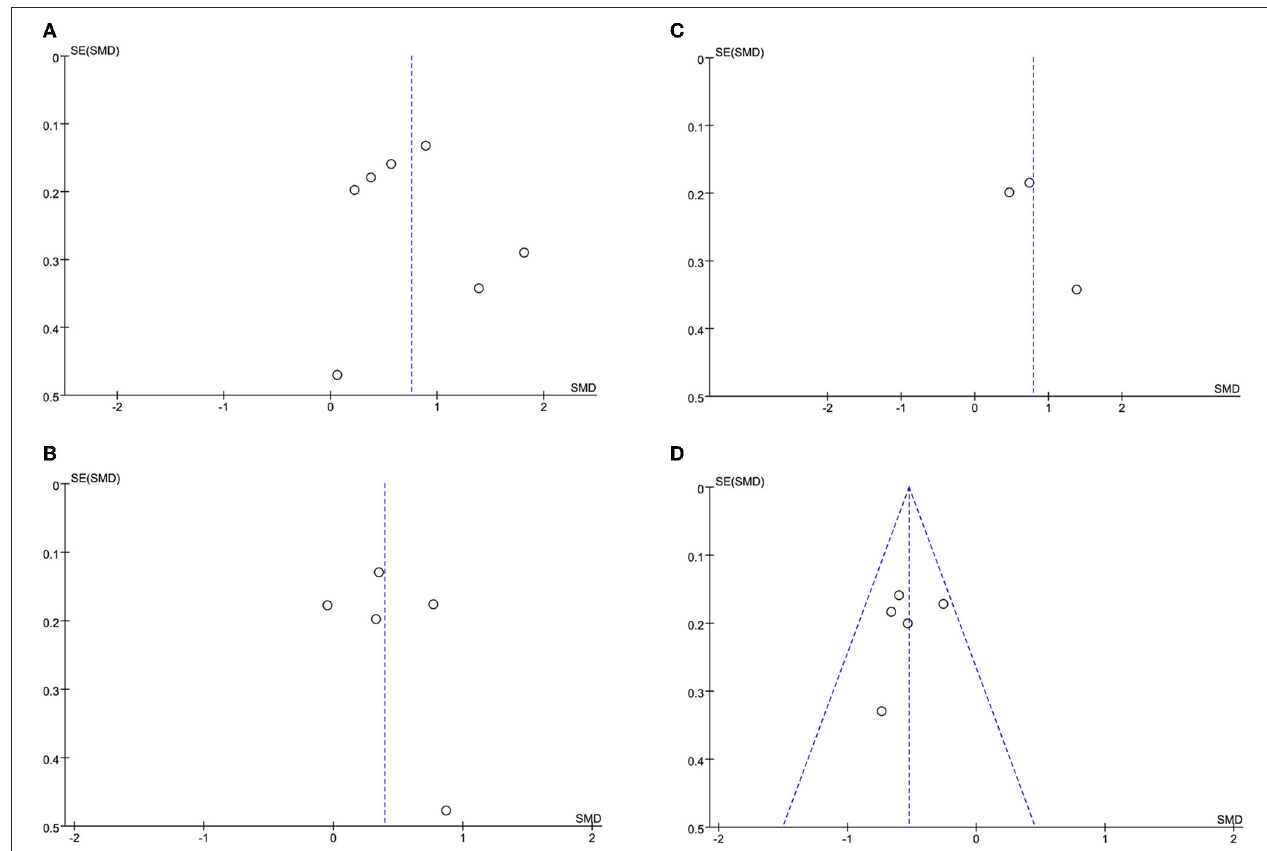
FIGURE 7 | (A) CRP funnel plot . (B) WBC funnel plot. (C) D-dimer funnel plot. (D) Lymphocyte count funnel